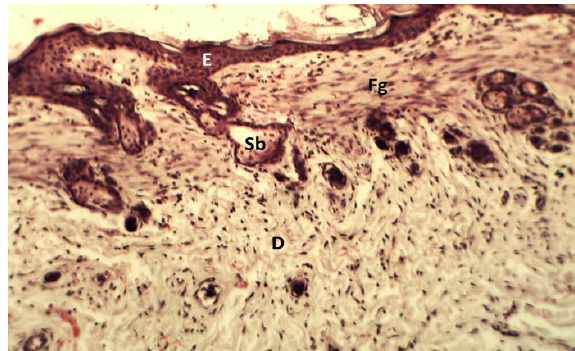
Figure, 19: Section of skin (28 days post treatment with amniotic membrane) shows complete epithelization (E) dermis (D) and sebaceous gland (Sb). H and E, 100 x.